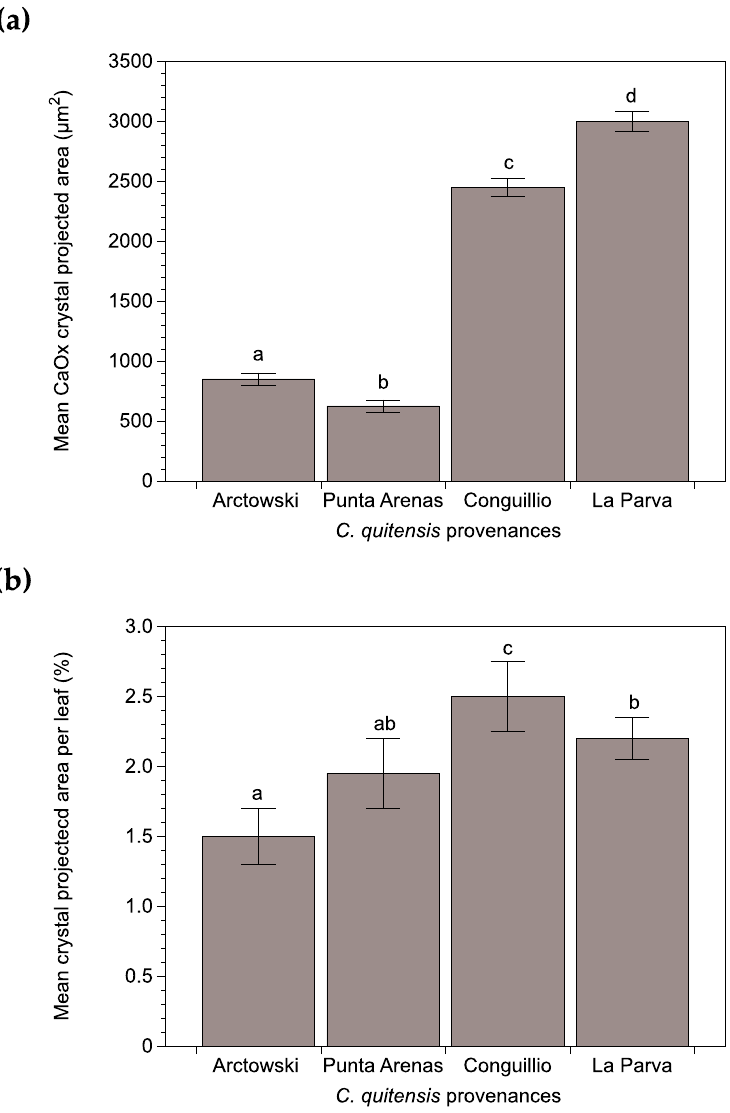
Figure 2. Calcium oxalate crystals accumulation in four provenances of Colobanthus quitensis ( a ) Mean CaOx crystals projected area and; ( b ) Relative projected area of CaOx crystals in the leaves of four provenances of C. quitensis . Error bars denote SE of mean; n = 5 cushions (10 leaves per cushion). Different letters represent statistically significant differences between provenances (One-way ANOVA; p < 0.05).